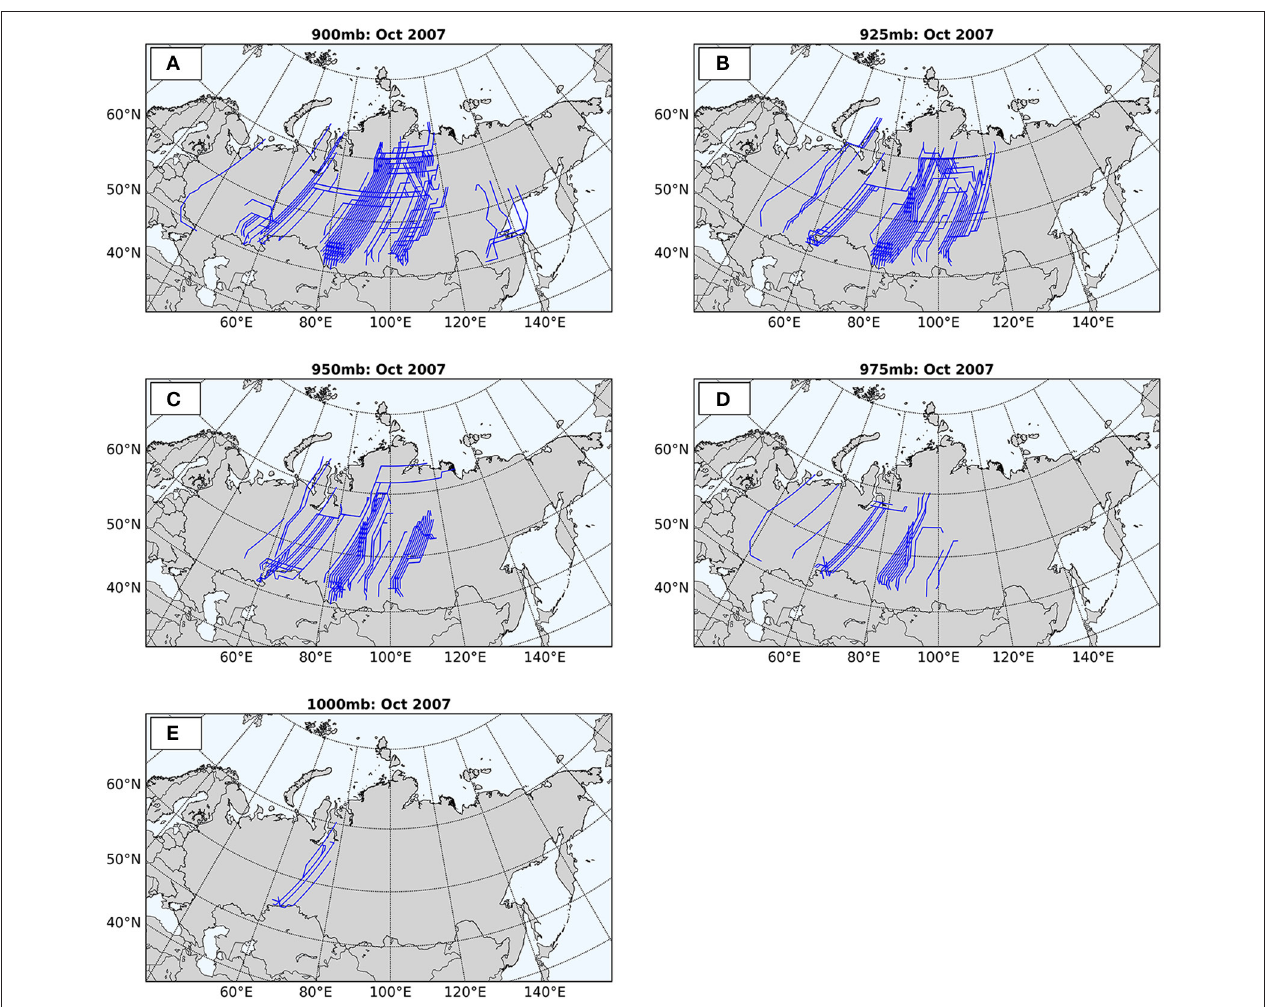
FIGURE 3 | Transport trajectory line maps for successful events for October 2007 at five different pressure levels: 900mb (A) ; 925mb (B) ; 950mb (C) ; 975mb (D) ; 1,000mb (E) . For illustration purposes only October 2007 is shown, but the pattern is representative of the generally observed decrease in the number of successful events with shallower injection heights across all months and